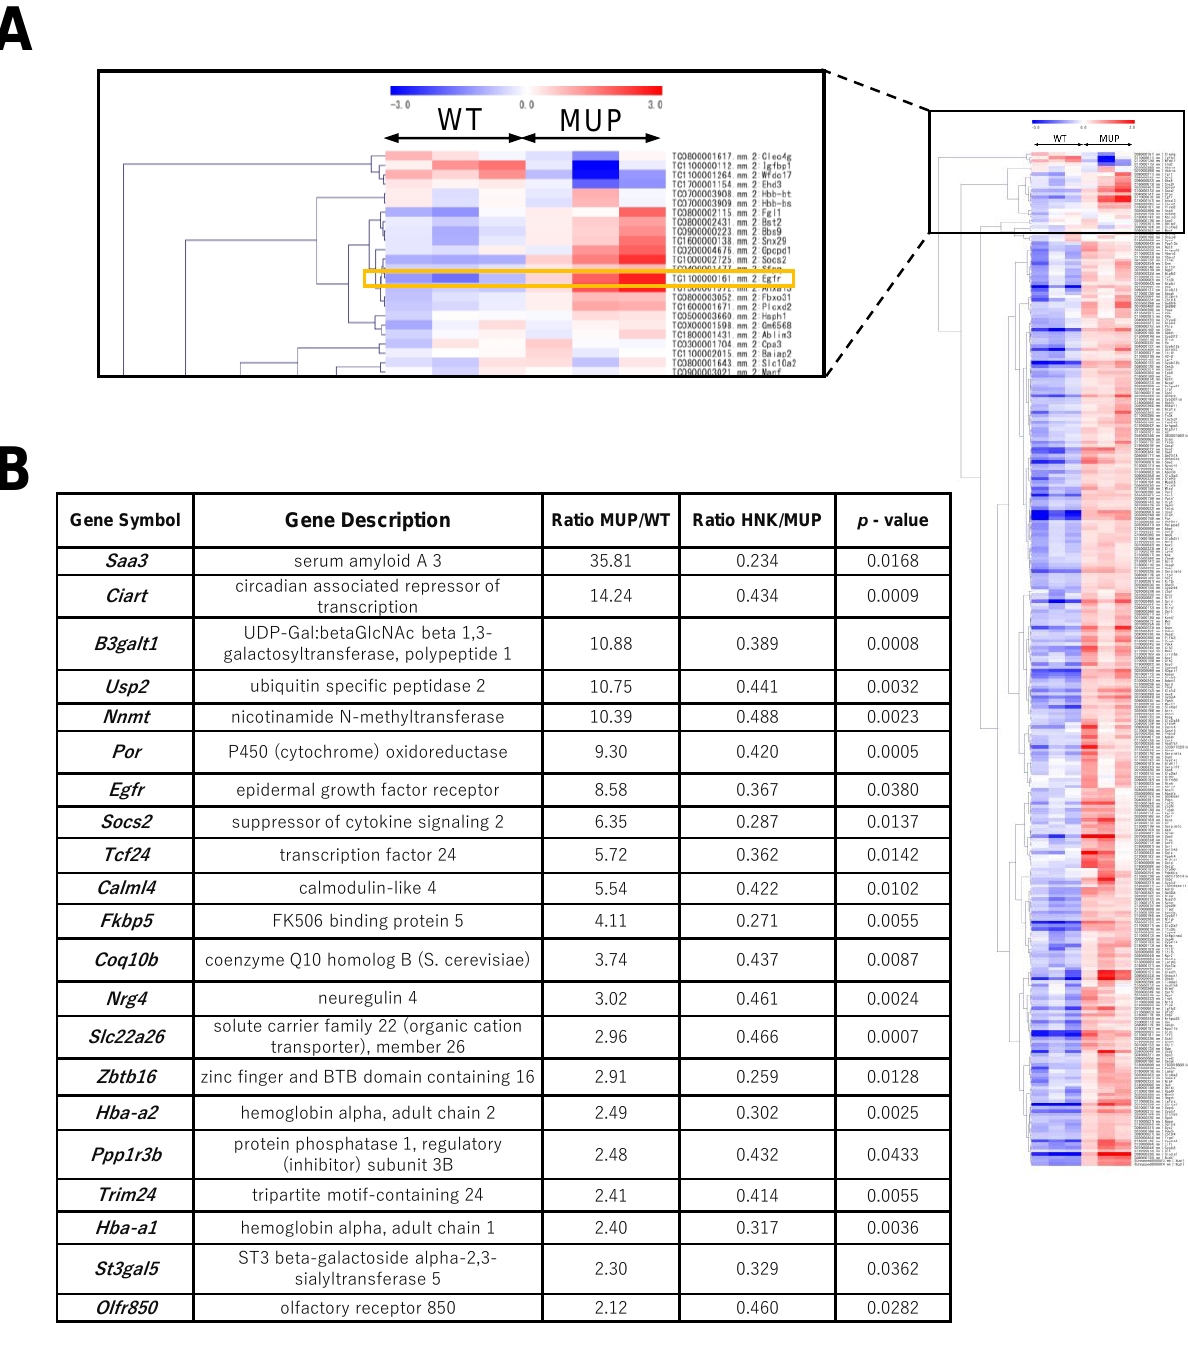
≥ 2.0-fold in the murine NASH liver and were downregulated ≥ 0.5-fold by HNK treatment ( p -value < 0.05, Figure 2B).